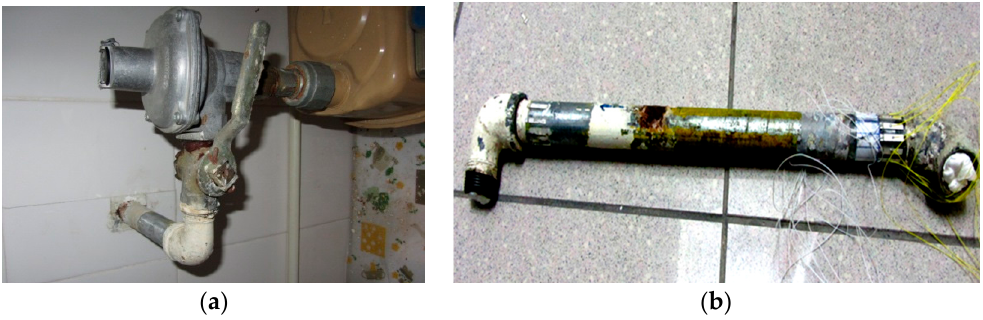
Figure 7. The in-service pipe used for the field test: the indoor portion of the pipe with rust starting at the entry of the concrete wall ( a ); and the corroded pipe with rusts after dissembled it from the concrete wall ( b ).